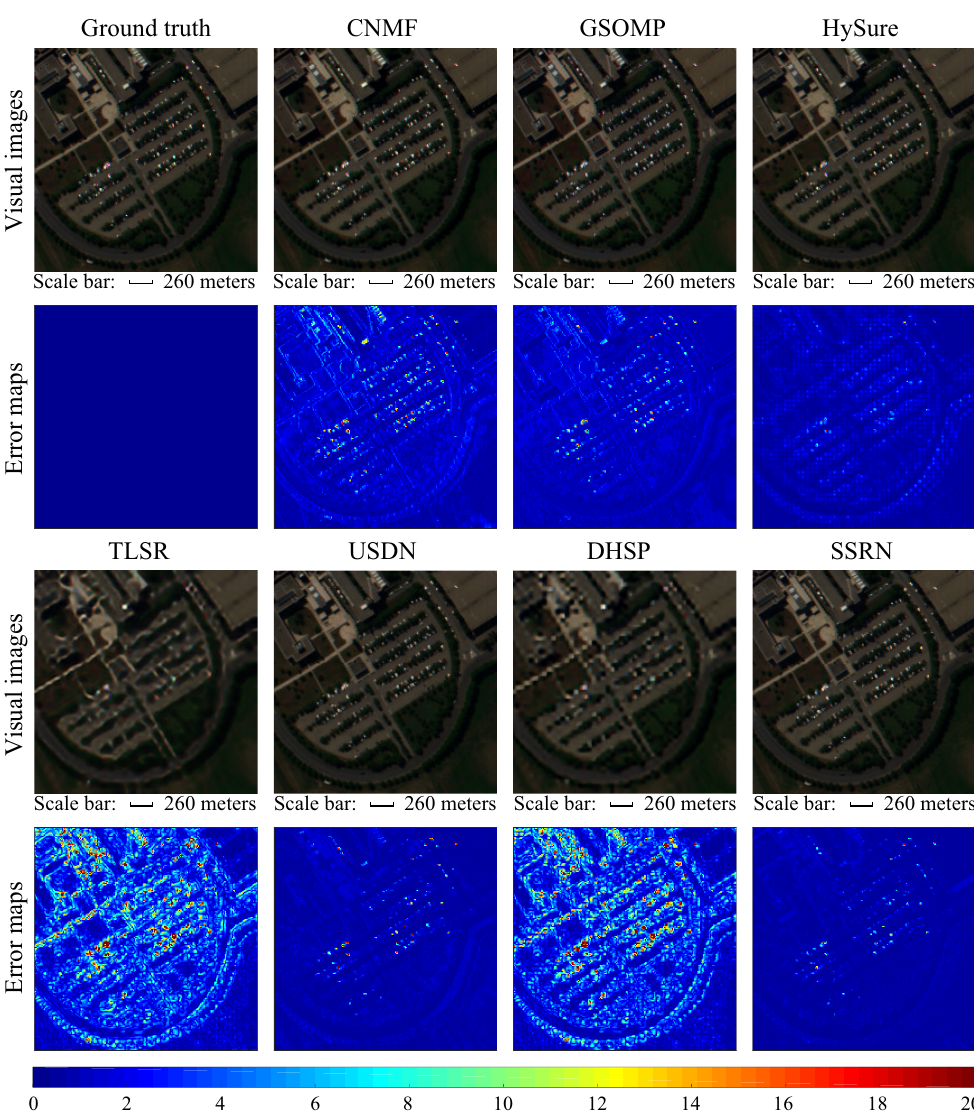
Figure 4. Visual images (R: 60, G: 30, and B: 10) and error maps of SSRN and the compared methods on the PU database. The error maps are the sum of absolute differences in all spectral bands between the estimated HSI and the ground